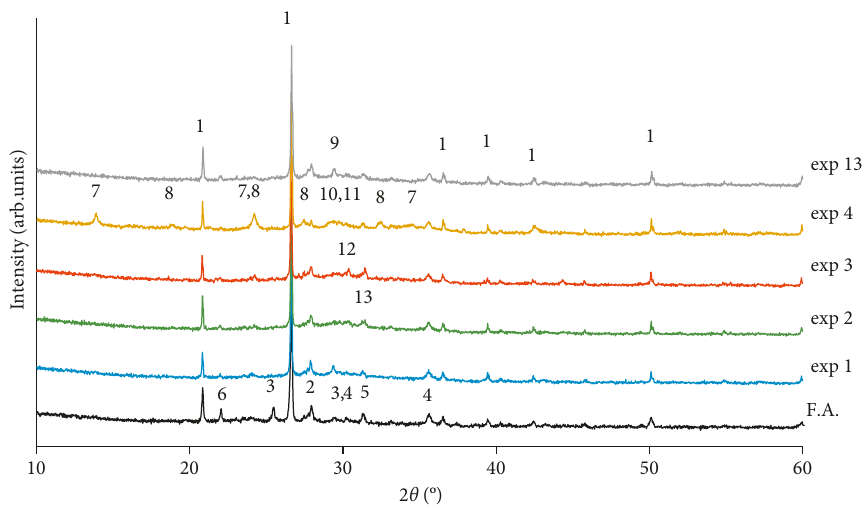
Figure 2: XRD patterns of fly ash and selected Si foamed geopolymers.1: quartz (PDF: 46-1045), 2: albite (PDF: 20-0554), 3: anhydrate (PDF: 03-0377), 4: maghemite (PDF: 04-0755), 5: ghelenite (PDF: 04-0690), 6: cristobalite (PDF: 03-0276), 7: hydroxysodalite (PDF: 89-9098), 8: hydroxycancrinite (PDF: 31-1272), 9: natrite (PDF: 37-0451), 10: calcite (PDF: 47-1743), 11: potassium carbonate (PDF: 70-0292), 12: sodium bicarbonate (PDF: 15-0475), and 13: potassium bicarbonate (PDF: 70-0995).